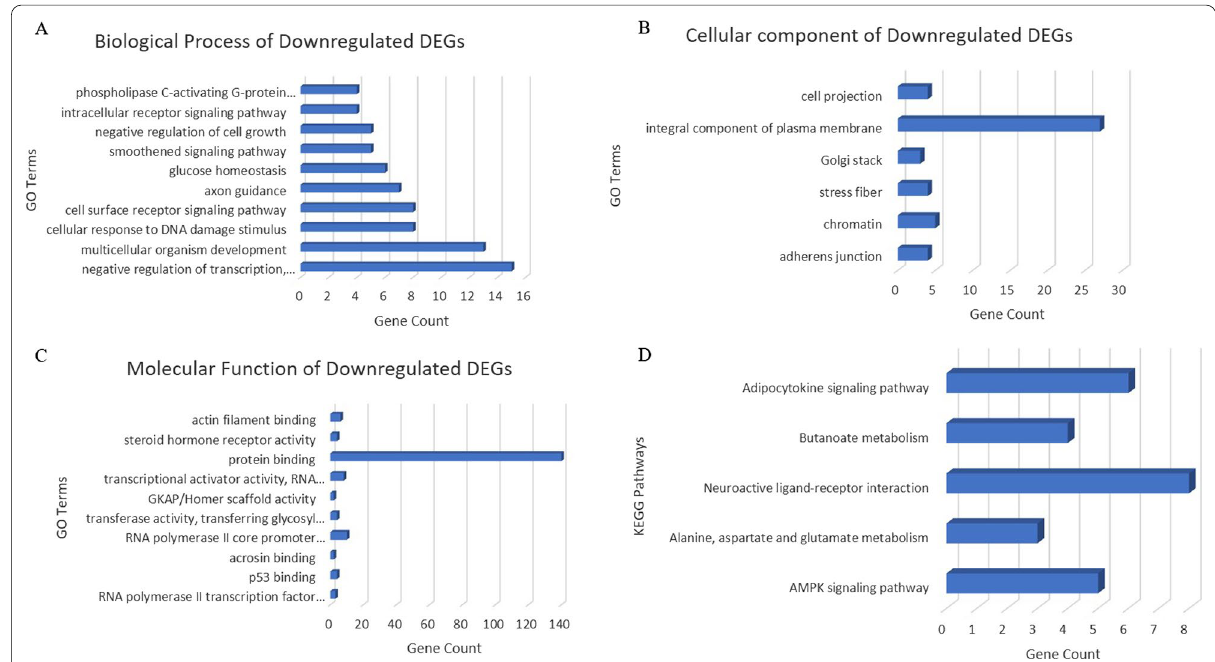
Fig. 3 The results of top down regulate DEG’s GO functional enrichment study. A biological process, a cellular component, a molecular function, and KEGG pathways are all examples of biological